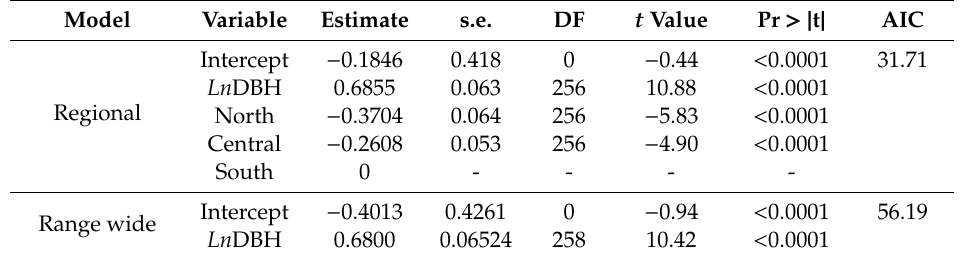
Table 7. Bark thickness (BT) model for dominant and codominant redwoods in the northern, central, and southern parts of redwood’s natural range (regional model) and for all the data combined (range-wide model). Generalized linear model for the natural log ( Ln )-transformed BT (mm) as a function of DBH (mm).